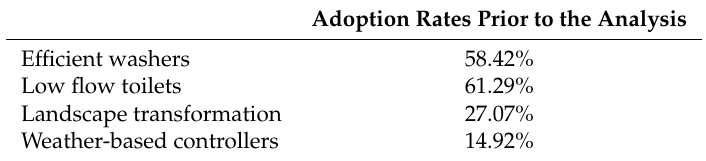
Table 6. Rates of water-efficient technology adoption prior to the analysis (% of the